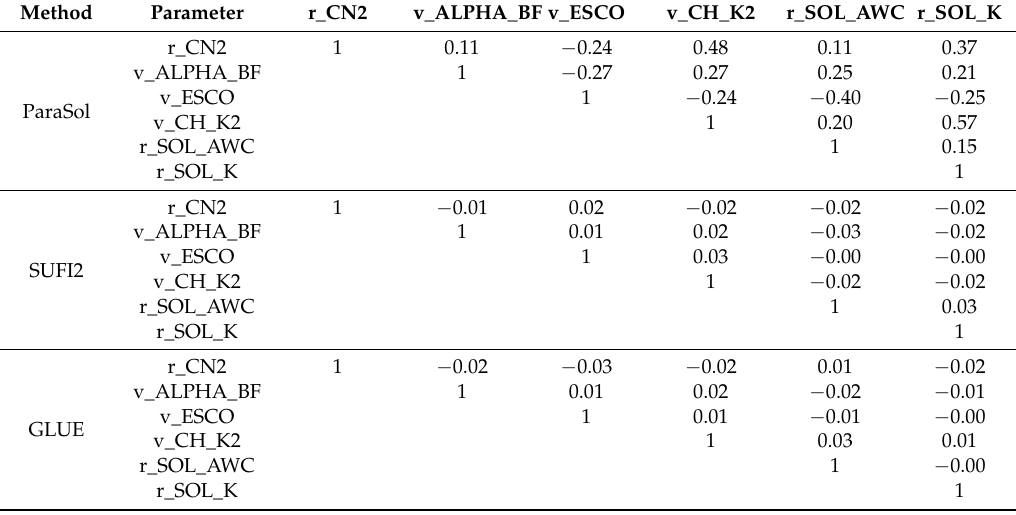
Table 4. Correlation matrix of the streamflow parameters yielded by ParaSol, SUFI2, and